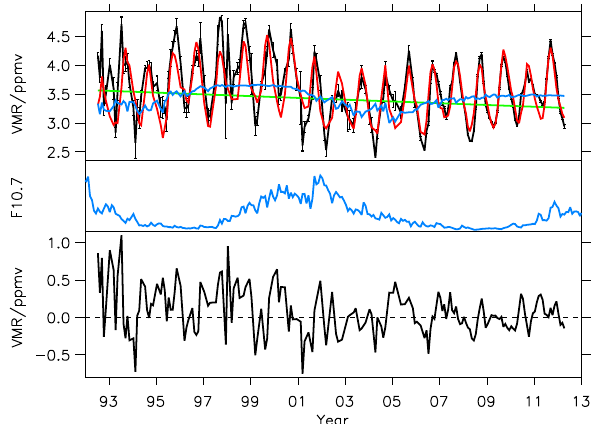
Figure 6. The root mean square improvement of the fit residual with respect to the standard approach gained by the inclusion of the so- lar cycle approximated by the F10.7 proxy as described under Ap- proach 2 in Sect. 4.2. White bins are positive values, i.e. deteriora- tion of the fit.